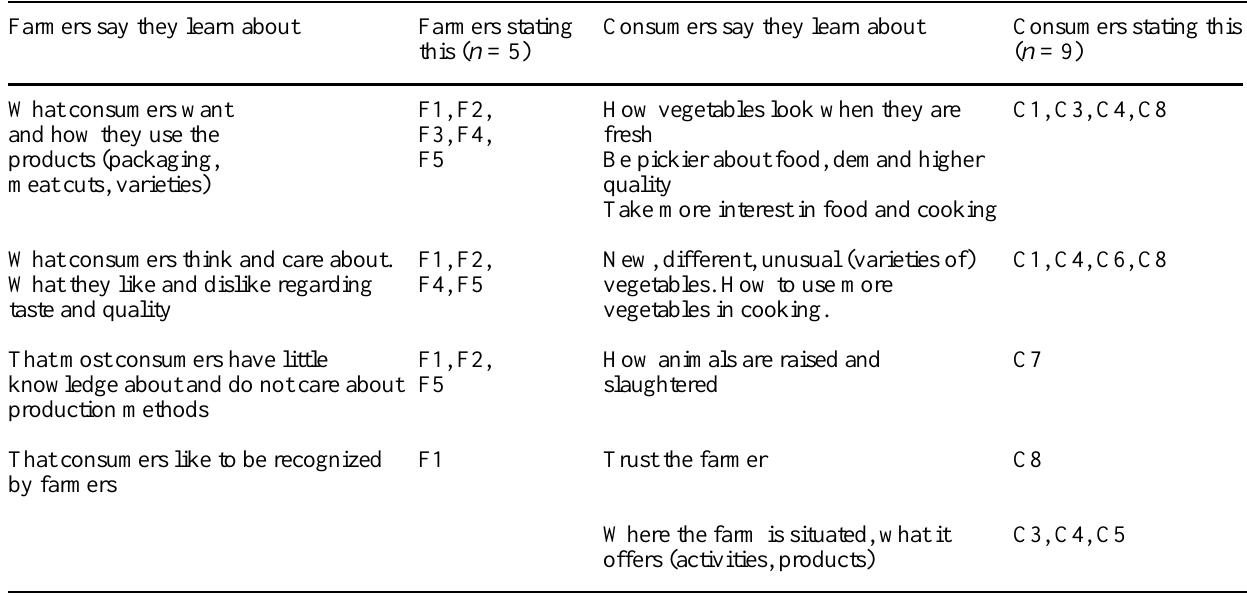
Farmers say they learn about Farmers stating